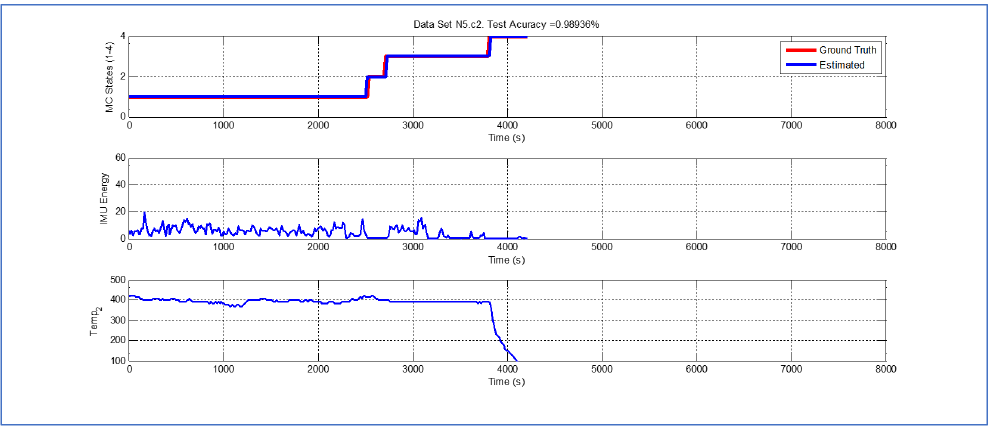
Figure 11. Detection of berry harvesting stages. Dataset N 5 c 2